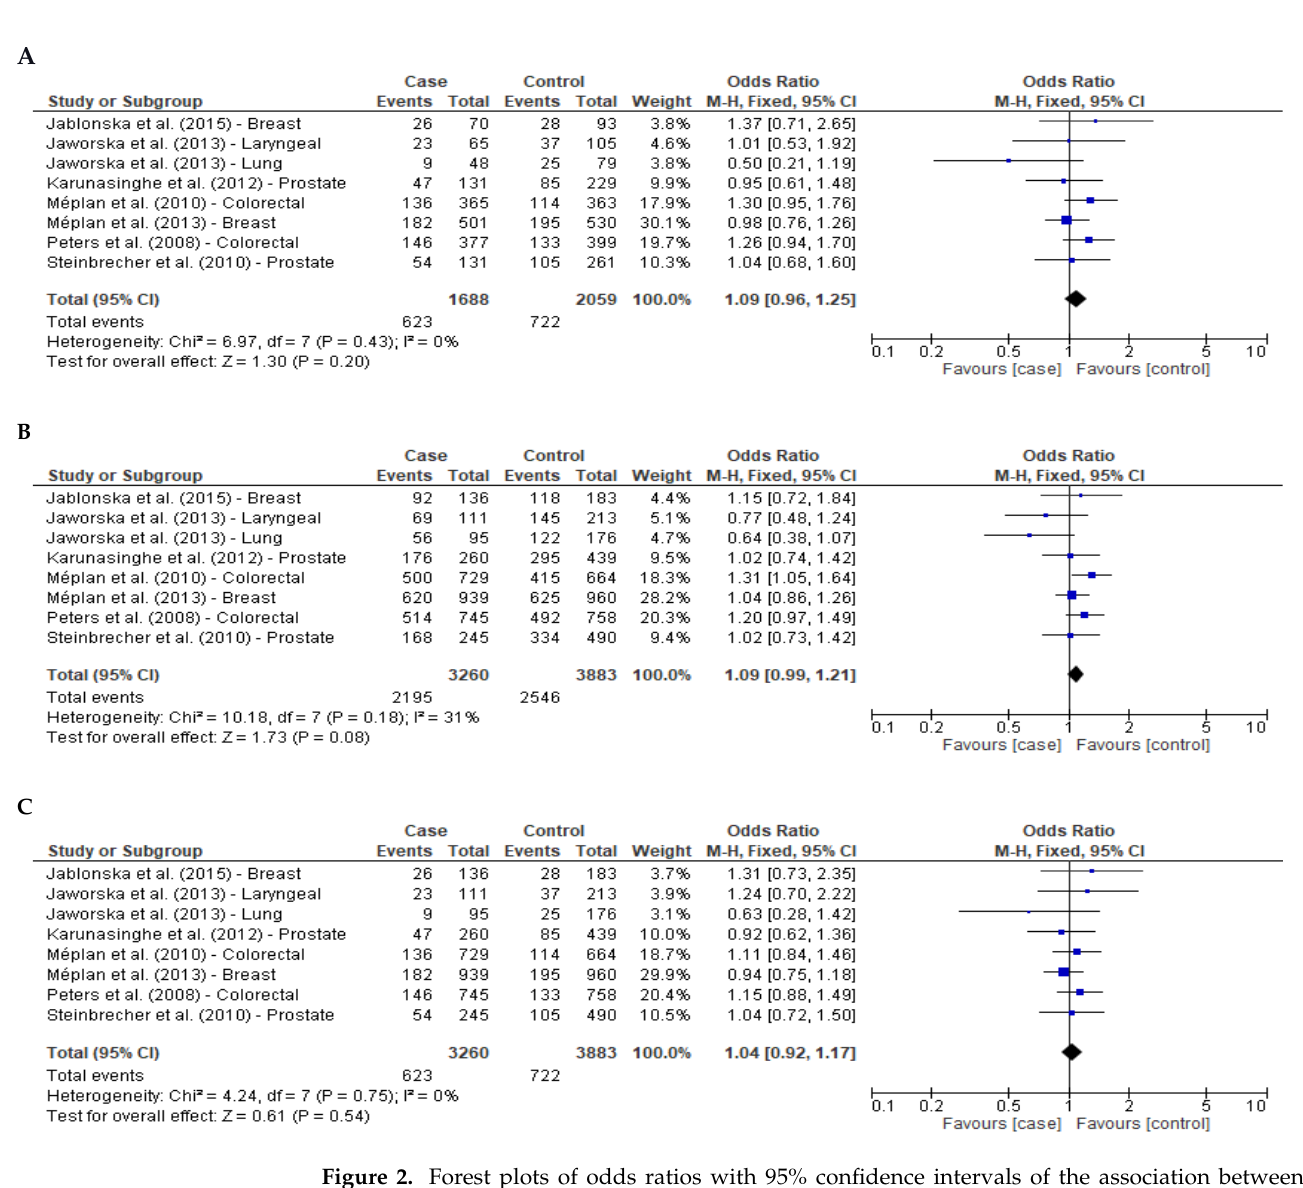
OR, 1.09; 95% CI, 0.99–1.21; p = 0.08; C—recessive model: OR, 1.04; 95% CI,